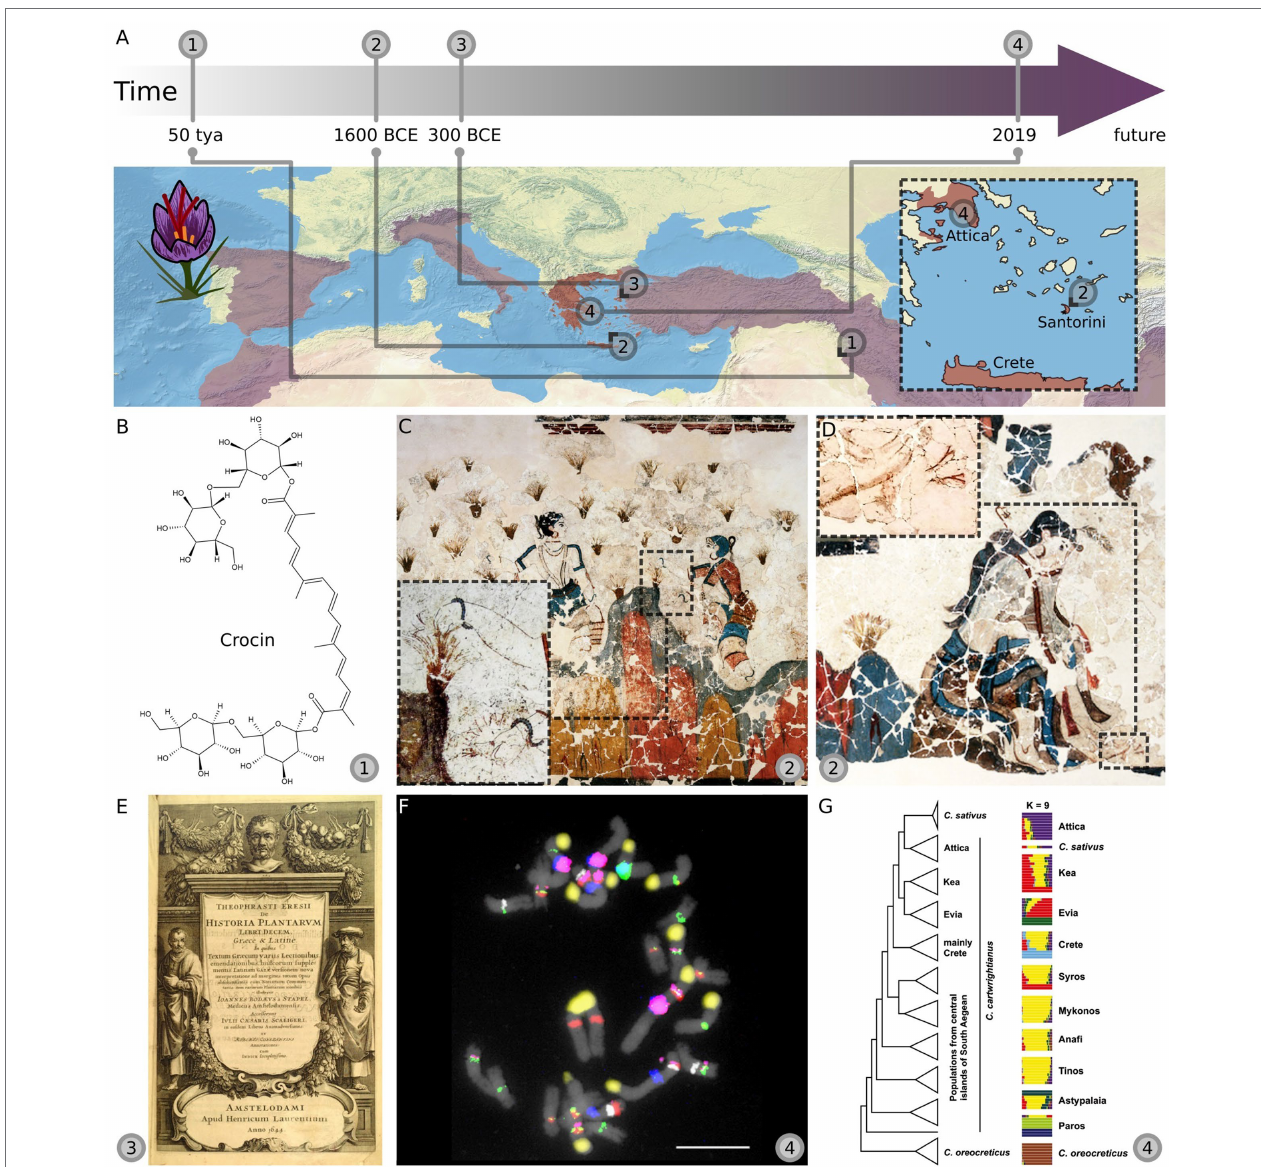
FIGURE 1 | Cultivation of saffron ( Crocus sativus L.) as traced by historic arts and modern genetics. (A) The timeline and map show four exemplary time-points (1–4) and their corresponding geographic locations. (B) The earliest evidence of “historic saffron” (any crocus species with at least partially similar traits as today’s cultivated saffron and used by humans for this particular trait) use was found in pigments from cave wall paintings. These contained crocin (structure shown) that was derived from Crocus flowers. These cave paintings were found in today’s north western Iraq and were created about 50,000 years ago (tya). (C,D) The first signs of saffron cultivation were found in Aegean Bronze Age frescoes from Crete and Santorini, dating back to 1700 to 1500 before the common era (BCE). Shown here is a part of “The Saffron Gatherers” (C) and “Adorants” frescos (D) , both found in Xeste 3 (Akrotiri, Santorini) from around 1600 BCE. (E) The first mentioning of saffron crocus propagation through corms was documented in Historia Plantarum by Theophrastus around 300 BCE. Shown here is the front cover of the Latin translation (1644). (F,G) Recent studies investigating the origin of saffron crocus using modern genetic approaches [multicolor FISH (F) and genotyping-by-sequencing GBS (G) ] also point to early Greece as the place of origin, with Attica as the most likely region of origin. Countries that are major saffron-producers today are colored in red and purple on the map (Rukša ̄ ns, 2017). [ Image sources: (A) The map was generated with Natural Earth (https://www.naturalearthdata.com/); (B) Crocin structure was made with ChemSketch; (C,D) “The Saffron Gatherers” and “Adorants” pictures from Doumas (1992) p. 152/Figure 116, p. 136/Figure 100 (contrast and brightness enhanced, layered); (E) Historia Plantarum belongs to the public domain, image provided by Andrew Dalby (Wiki commons); (F) FISH image reused from Schmidt et al. (2019), Figure 2Q with permission from John Wiley and Sons; (G) Phylogenetic tree and cluster analysis reused from Nemati et al. (2019) under CC-BY]. The timeline is not to